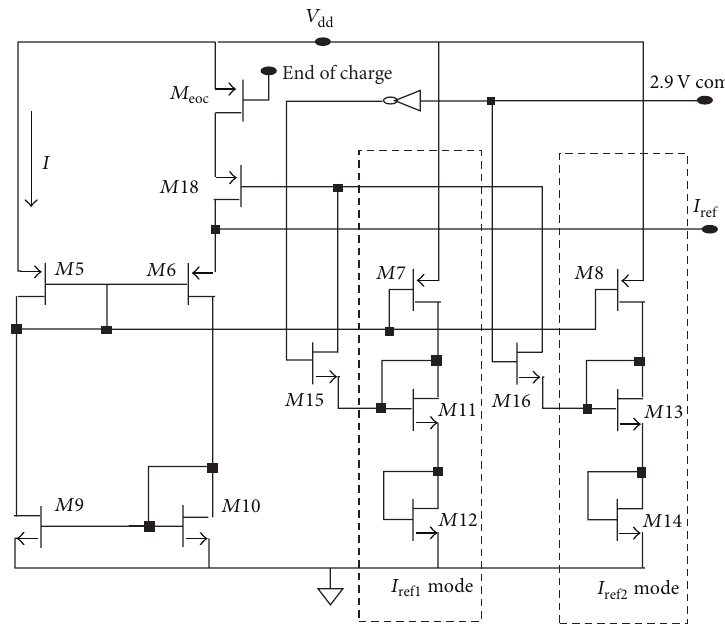
Figure 5: Current generator